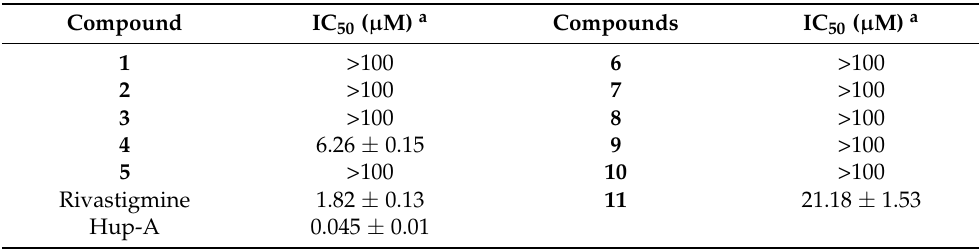
Table 4. Acetylcholinesterase inhibitory activities of the secondary metabolites of Phaeosphaeria sp. LF5, expressed as IC 50 values.